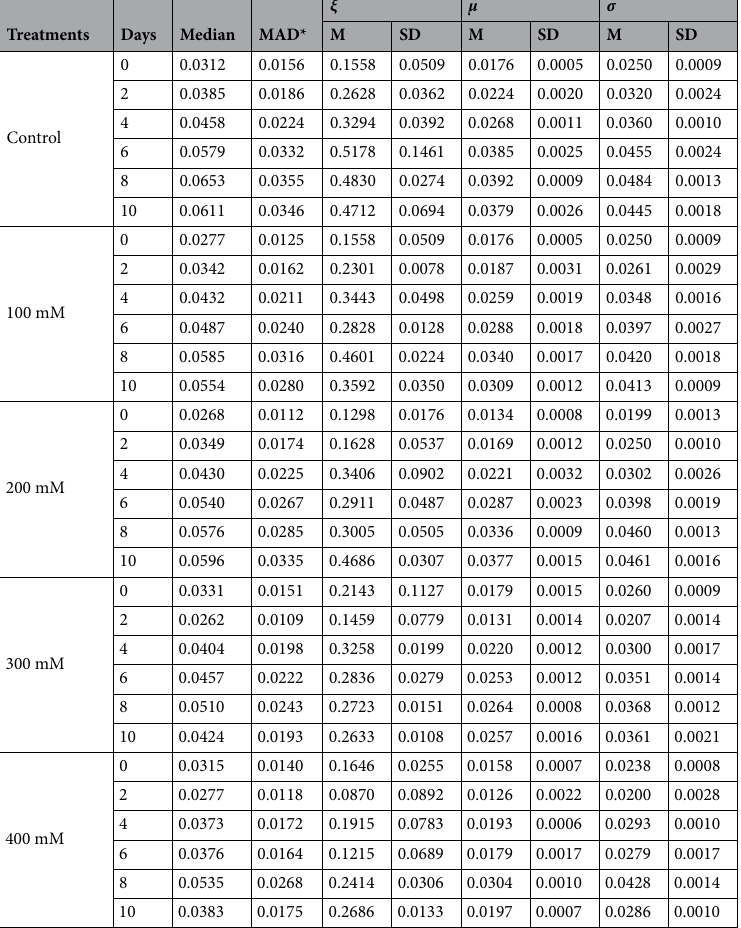
Table 1. Summary of statistical analysis of s 3 obtained by measuring seedlings. *Median absolute